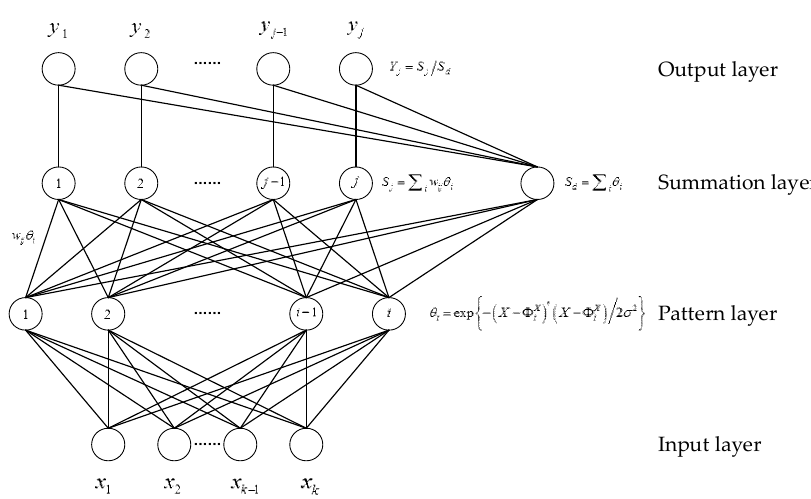
Figure 1. Basic architecture for generalized regression neural network (GRNN) [29].